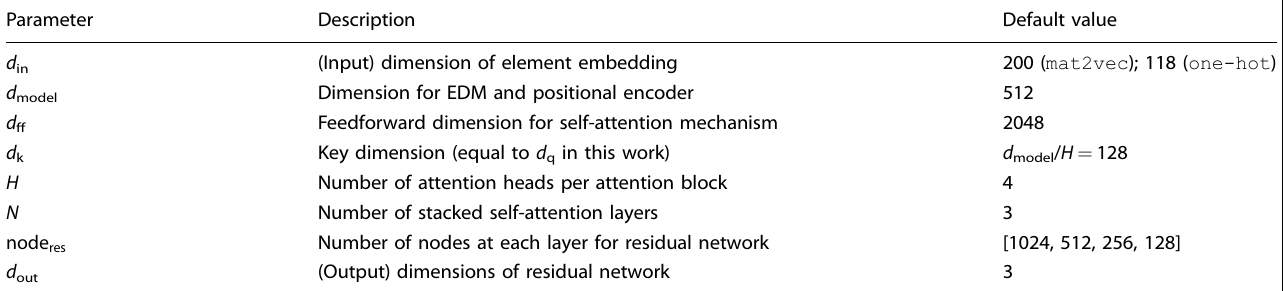
Table 2. List of default model parameters of CrabNet .